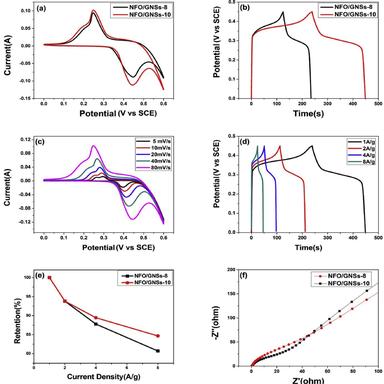
(a) CV curves at 80 mV\$s 1 and (b) GCD curves at 1 A g1 of NFO/GNSs-8 and NFO/GNSs-10; (c) CV curves at different scanning speed and (d) GCD behaviors at various current density for NFO/GNSs-10; (e) rate performance of NFO/GNSs-8 and NFO/GNSs-10; (f) electrochemical impedance spectroscopy of NFO/GNSs-8 and NFO/GNSs-10.